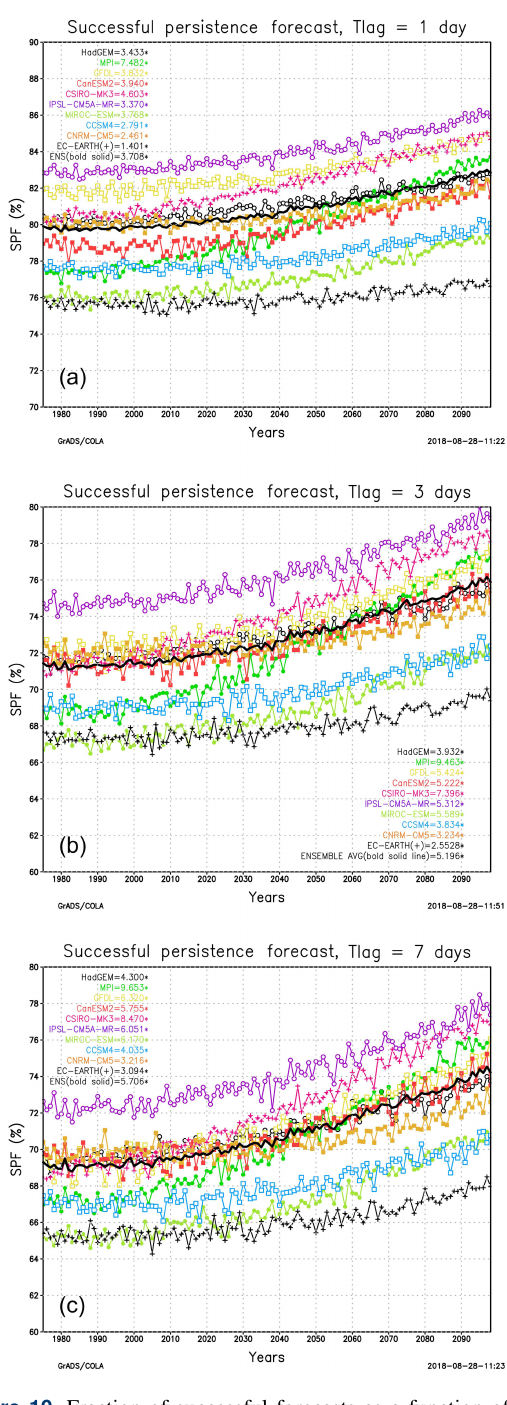
Figure 10. Fraction of successful forecasts as a function of time using persistence for daily precipitation occurrence at time lags of (a) 1 day, (b) 3 days and (c) 7 days for the GCM ensemble of Giorgi et al. (2014a) (bold black line). The number in parenthesis denotes the trend in % per 100 years. Units are percentage of days in 1 year for which persistence provides a successful forecast (either dry or